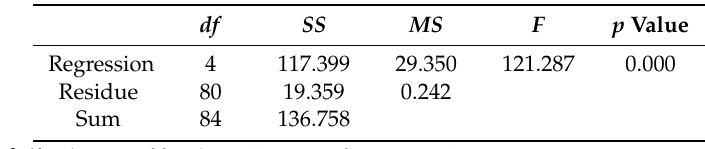
Table 3. Analysis of variance testing fitting ability of quantitative structure-activity relationship to training dataset a .